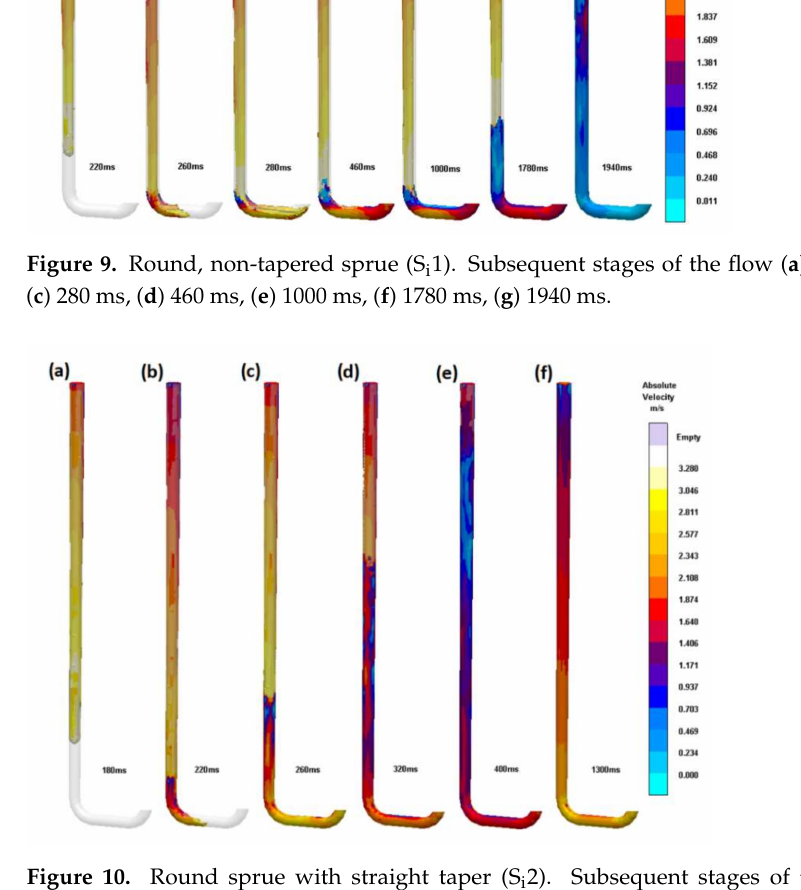
Figure 10. Round sprue with straight taper (S i 2). Subsequent stages of the flow ( a ) 180